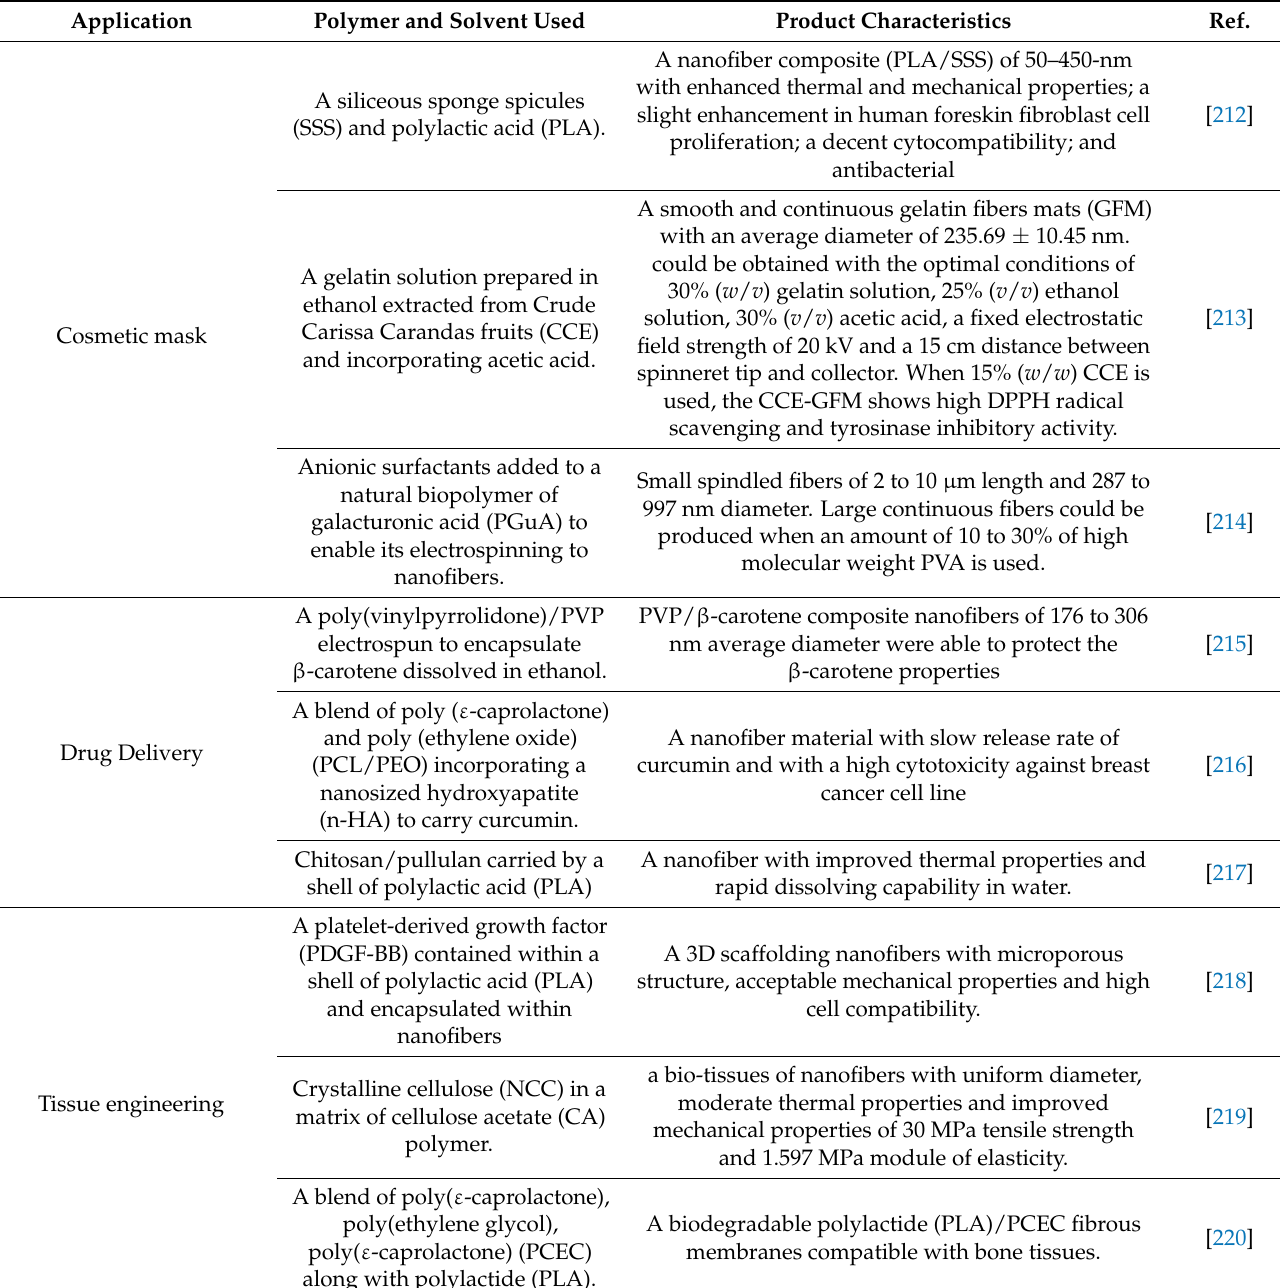
Table 1. Most important applications of the electrospun nanofibrous scaffolds in the last decade.